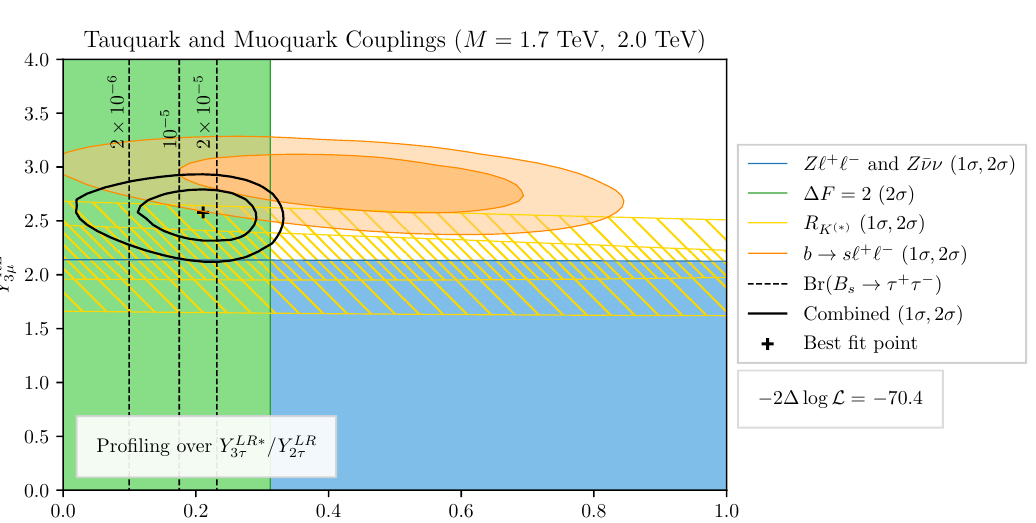
Figure 5. Top : bounds on the Φ 2 ,τ couplings Y LR and Φ effects to b → s‘ + ‘ − observables (orange). Our results are obtained by profiling over the 2 ,µ Φ contributions depending on the Y RL 2 ,µ ¯ D 0 − D 0 mixing (green), and large Y LR and leads to tension with Z‘ + ‘ − and Z ¯ νν data (blue). The figure also includes predictions for the B + τ − branching ratio. Bottom : the same solution presented in terms of the product s → τ and the muoquark coupling Y RL Y LR Y LR ∗ 2 τ 3 τ for the bounds originating from D 0 − ¯ D 0 mixing, as well as from the fit to Zτ + τ − and Z ¯ νν